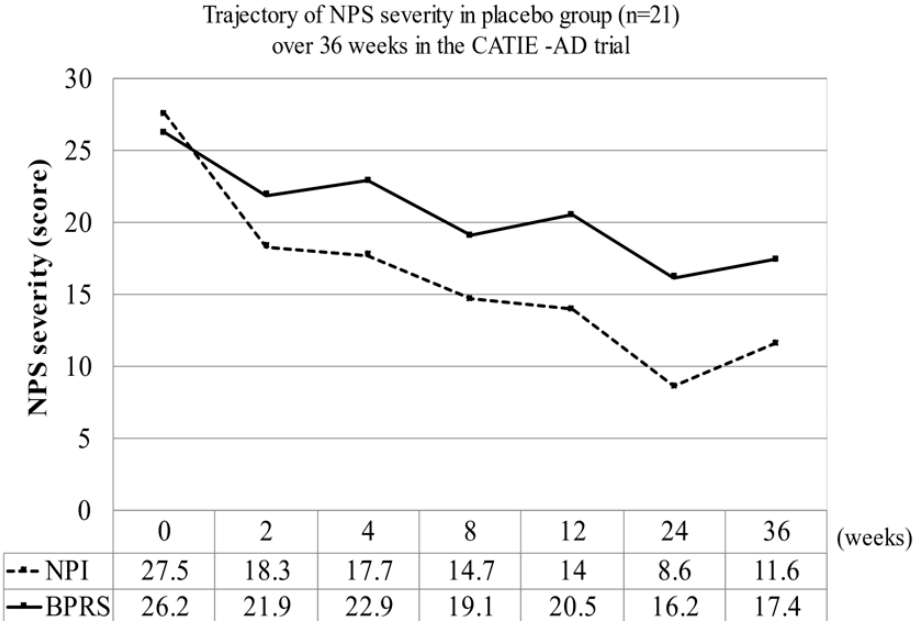
Figure 5. In the CATIE-AD trial, the NPS severity (BPRS or NPI scores) decreased in a placebo group to about 40–60% after 36 weeks. [108] Among the 77 subjects who completed the 36-week CATIE-AD trial, the NPI scores of the 21 patients in the placebo group decreased from 27.5 ± 17.1 to 11.6 ± 12.6 points, while the BPRS scores decreased from 26.2 ± 14.5 to 17.4 ± 114.1 points. Abbreviations :